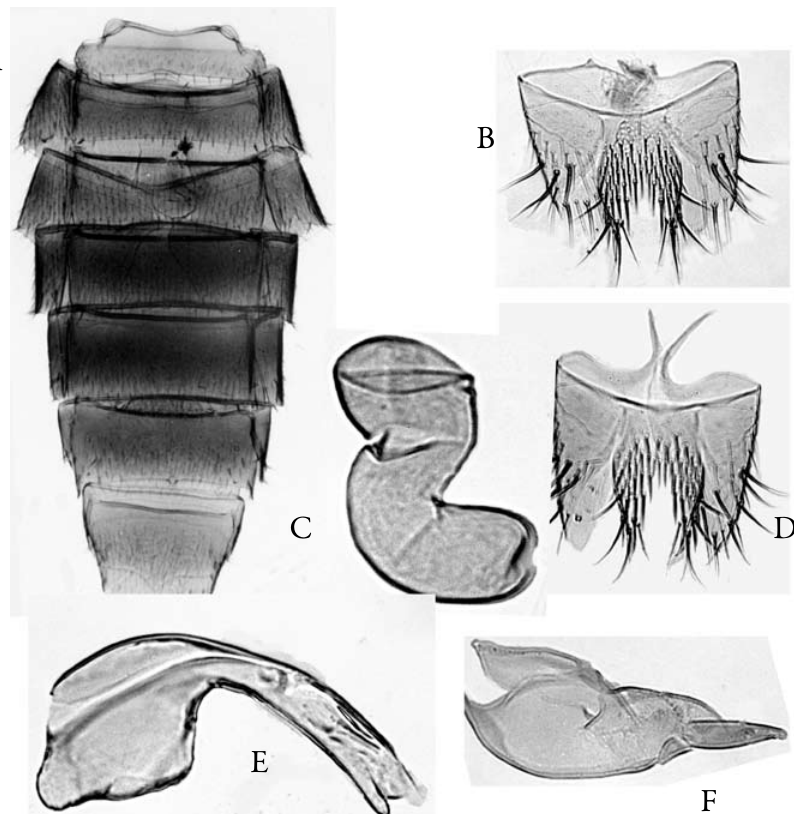
Fig. 5;. theta dominguesae ,: A, Abdominal segments II-VIII, dorsal; b, Female abdominal segment IX; c, Female spermatheca; D, Male abdominal segment IX; e, Male median lobe of male genitalia; F, Lateral lobe of male